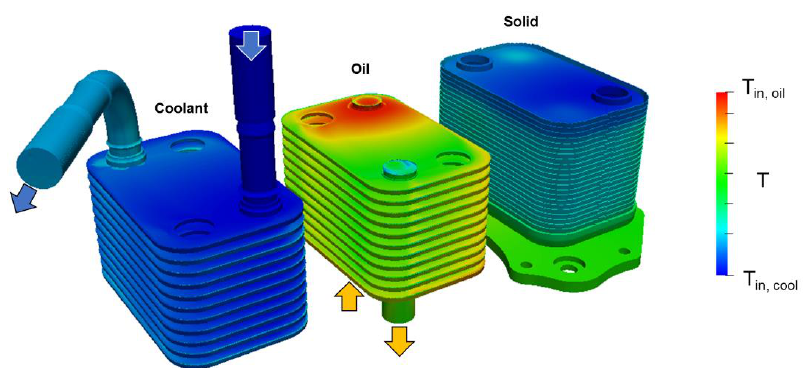
Figure 15. Cooler A: Temperature field on solid, oil and coolant regions. Operating conditions: Q oil = 50%, Q cool = 80%.